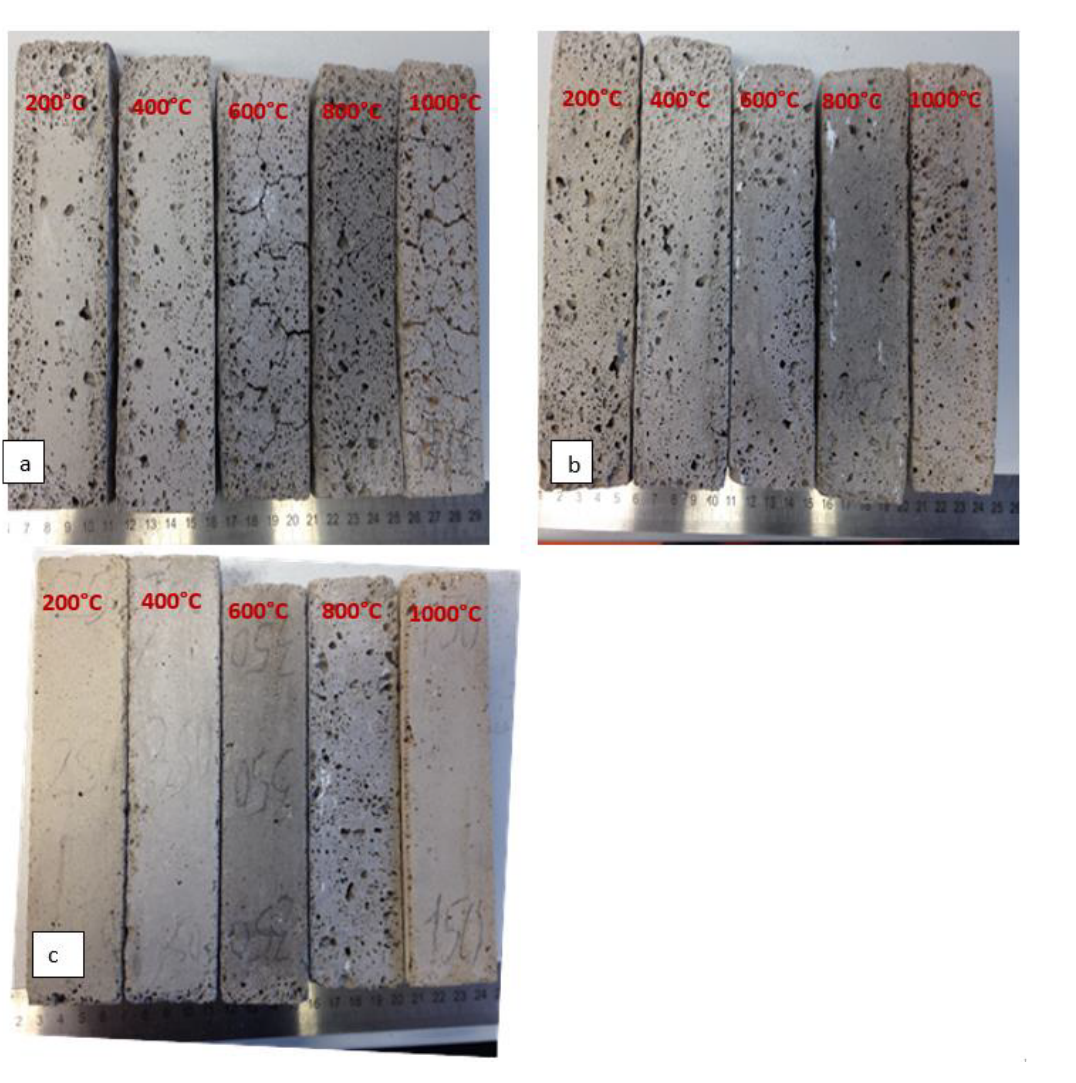
Figure 9: Colour change and cracks occurrence of geopolymer foams with different content of basalt waste fibre a) 10%, b) 30% and c) 50% after heating at various temperatures.